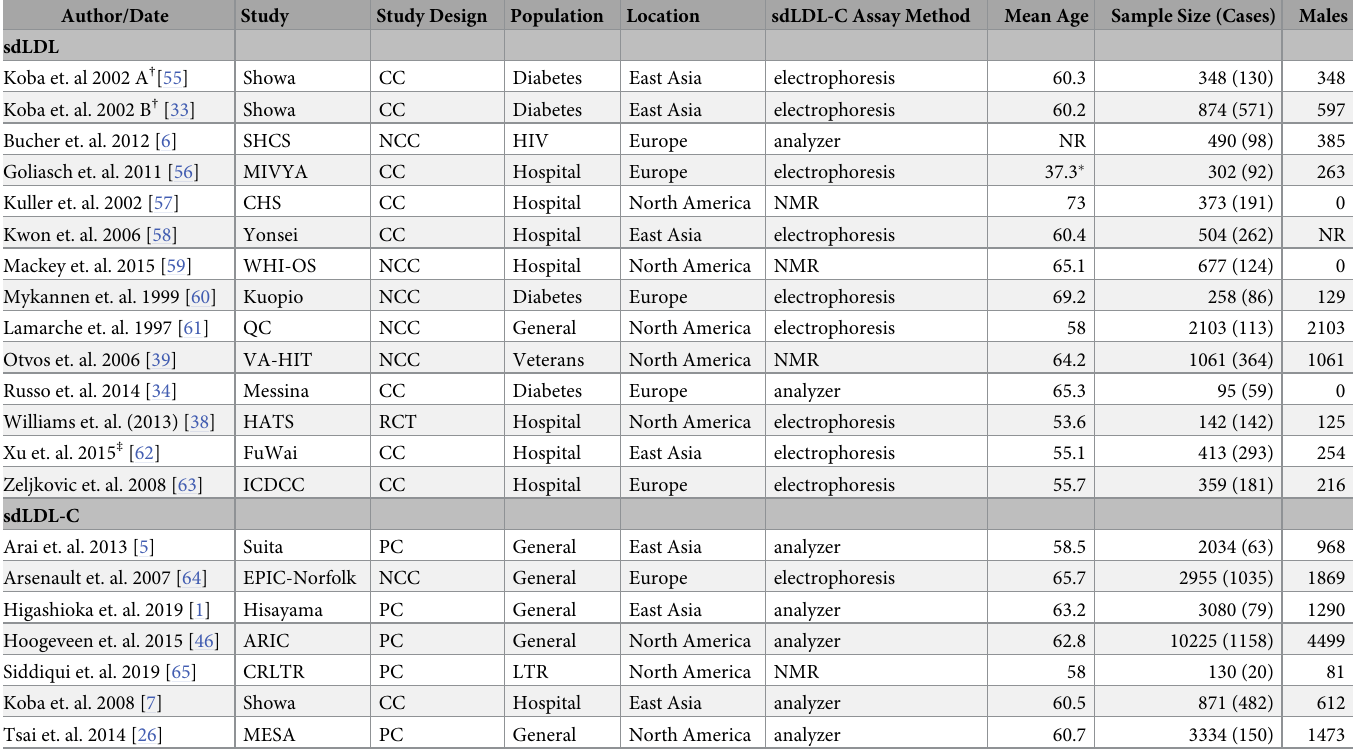
Table 1. Summary of studies of association between sdLDL/sdLDL-C and